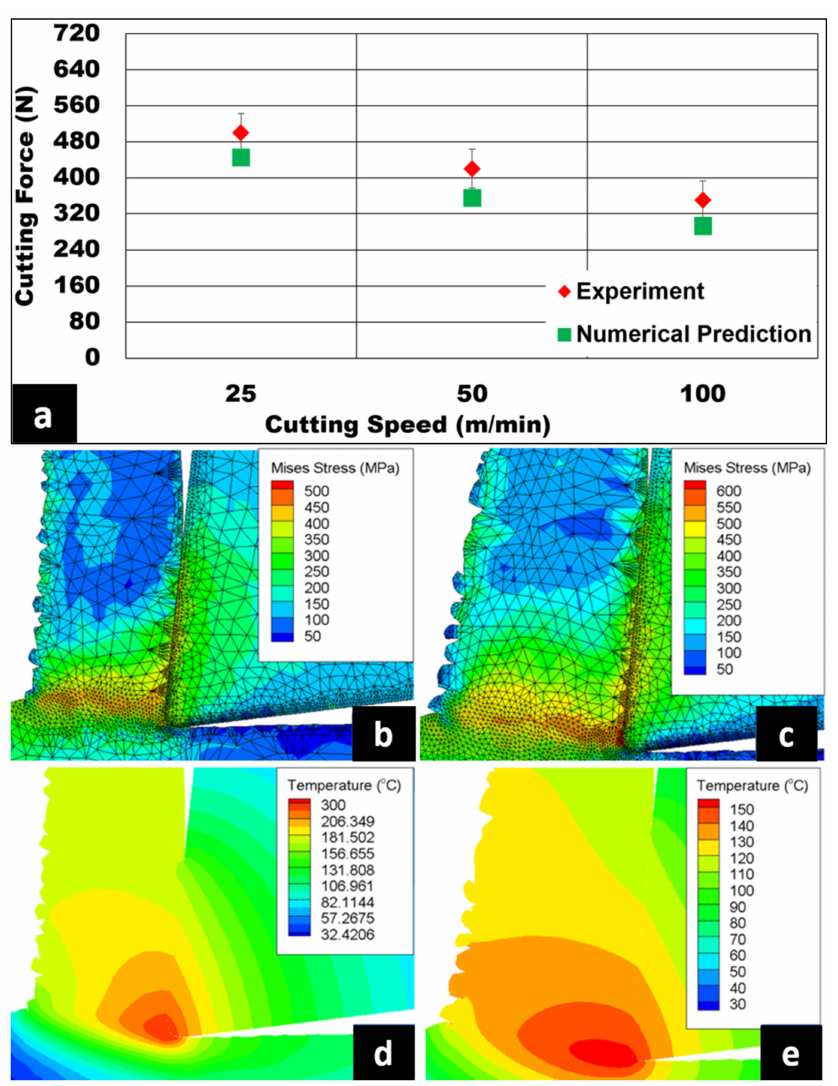
Figure 4. ( a ) Effect of the variation of the cutting velocity on machining forces (AdvantEdge TM simulation); 6061/hollow alumina shell syntactic foams (vol% = 10%, h = 0.07 mm, b = 3 mm, dry cut); Von Mises Stress contour at ( b ) 100 m/min and ( c ) 25 m/min; temperature contour at ( d ) 100 m/min and ( e ) 25